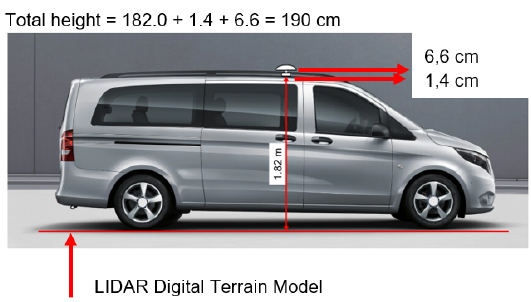
Figure 2. Precise absolute height information of GNSS antenna given a LIDAR DTM and the relative antenna height.